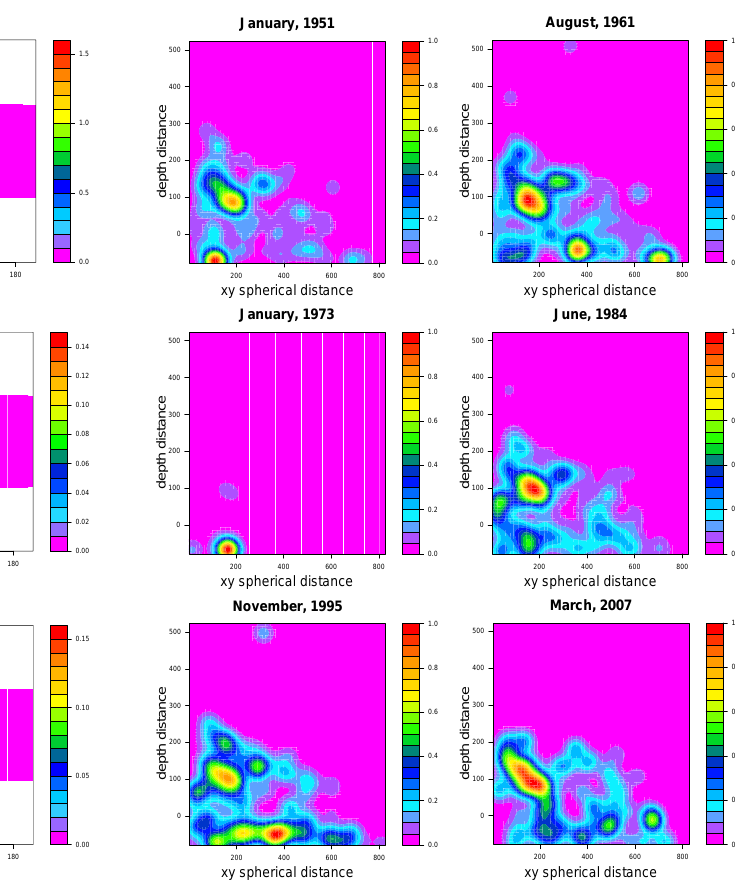
Fig. 9. 3-D space-time smoothed conditional intensity function around a fixed point at six different